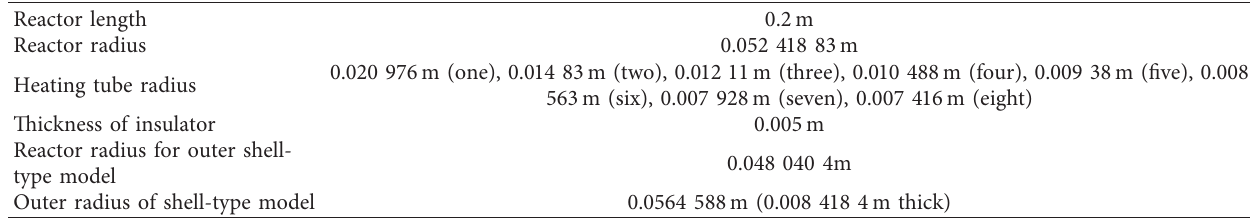
Table 1: Reactor